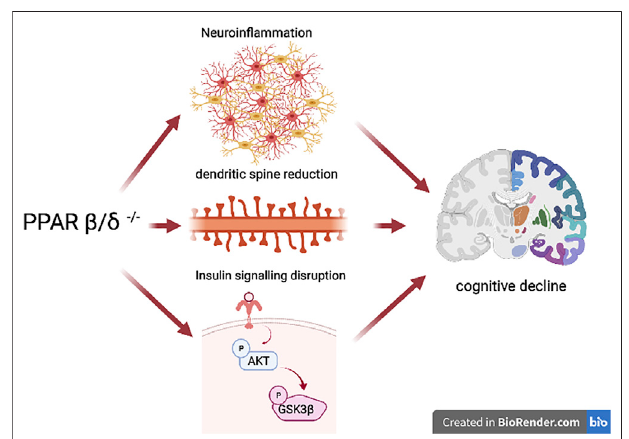
FIGURE 8 | Schematic representation of the effects of PPAR β / δ de fi ciency. The fi gure shows how this receptor is a key molecule in the development of some of the most important features of memory impairment such as neuroin fl ammation, reduction in the number of dendritic spines, aswellasanalterationofsynapticbiomarkers,andinsulinsignalingdisruption. In this way, this transcription factor represents a promising target for the treatment and improvement of memory impairment, an important hallmark of neurodegenerative